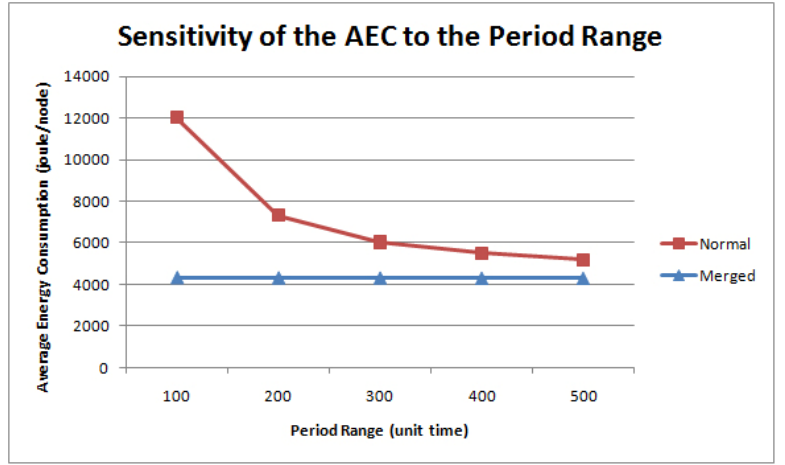
Figure 15. Sensitivity of the AEC to the period range.